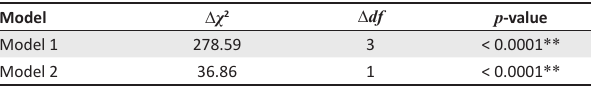
TABLE 3: Difference testing for competing measurement